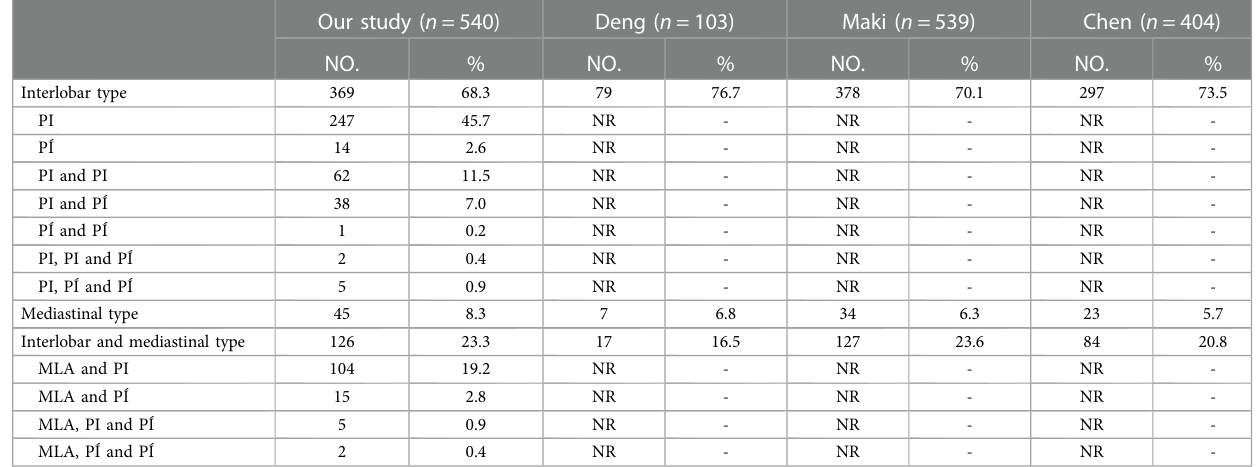
TABLE 4 Branching patterns of the lingular segment